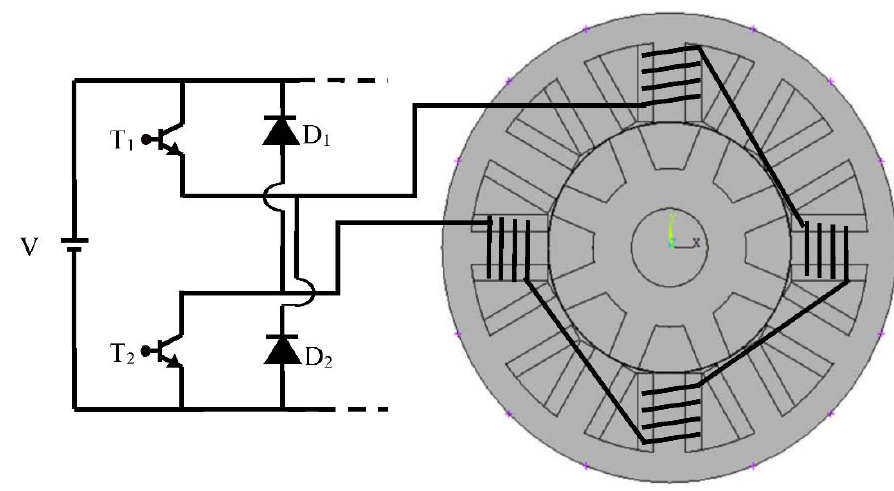
Figure 10. Synoptic schema of the 12/8 SRG associated with an asymmetric bridge converter.